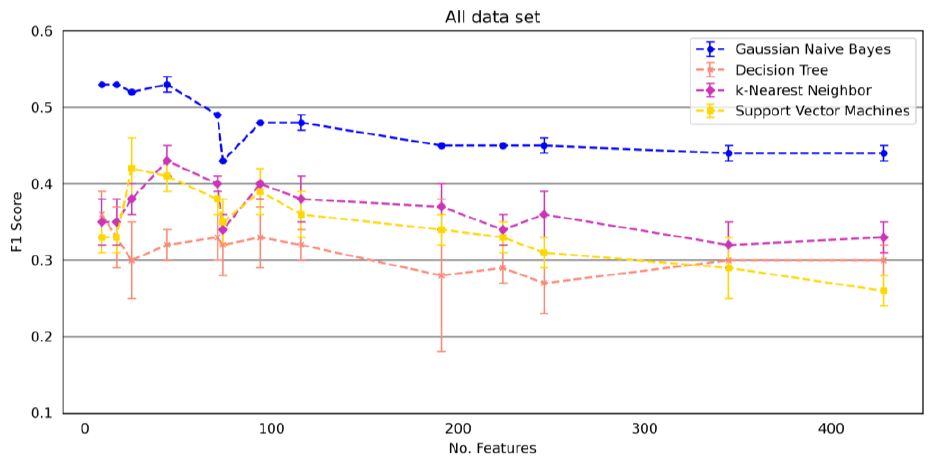
Figure 3. Classification performance (F1 score) of the four models on All data set depending on the number of features. The error bars present the mean and standard deviation across 5-fold cross- validation repetition. A dotted line maps the F1 score trend with increasing feature integer values. No assumption is made for the performance of feature subsets that lie between the data points. All data set = 25 Foot Walk Test + 2-minute walk test + Expanded Disability Status Scale + GAITRite System data sets + Mobility Lab Gait data sets + 12 item Multiple Sclerosis Walking Scale data set + Early Mobility Impairment Questionnaire data set.